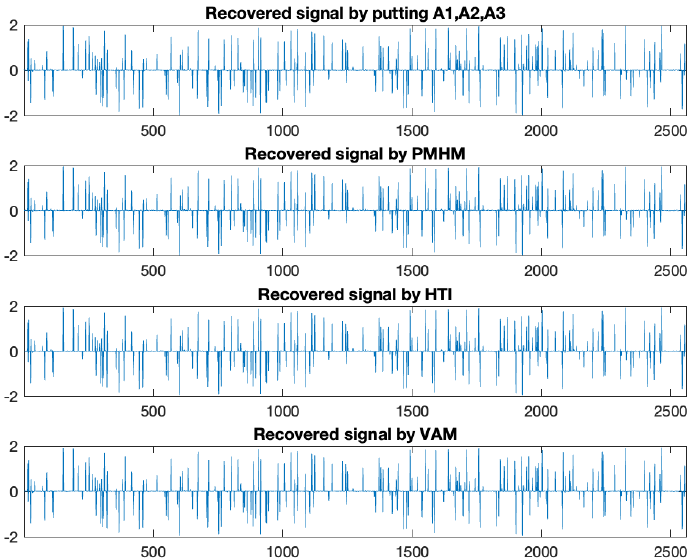
Figure 16. The recovered signal with m = 210 by A1A2A3 (37 Iter, CPU = 1.8094), PMHM (264 Iter, CPU = 2.4789), HTI (130 Iter, CPU = 2.0365), and VAM (60 Iter, CPU = 2.0194), respectively.